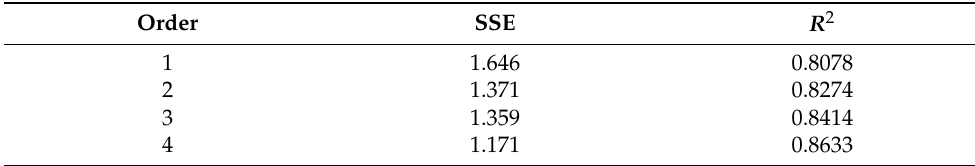
Table 6. SSE and R 2 of first to fourth order